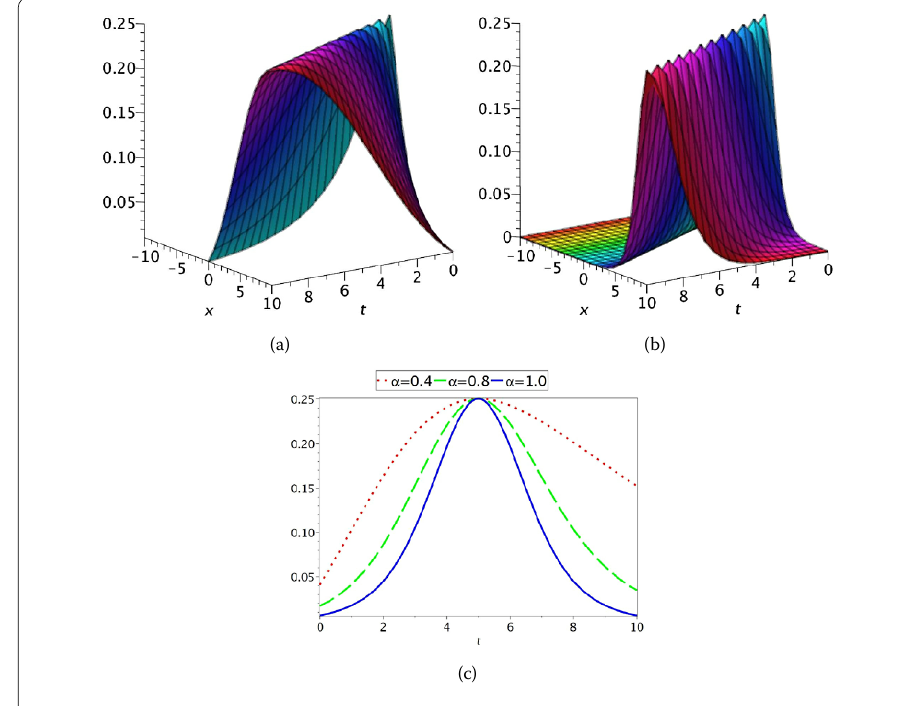
Figure 1 Dark soliton solution of u 1,1 ( ξ )